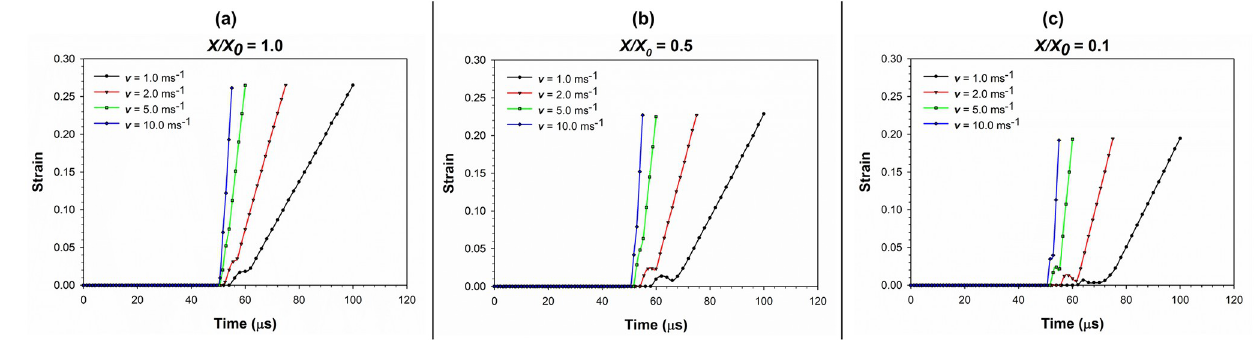
Fig 13. Variation of strain with time during the cell compression simulation as affected by varying compression rates. (a) fresh cells ( X/X 0 = 1.0); (b) moderately dried cells ( X/X = 0.5); (c) extremely dried cells ( X/X 0